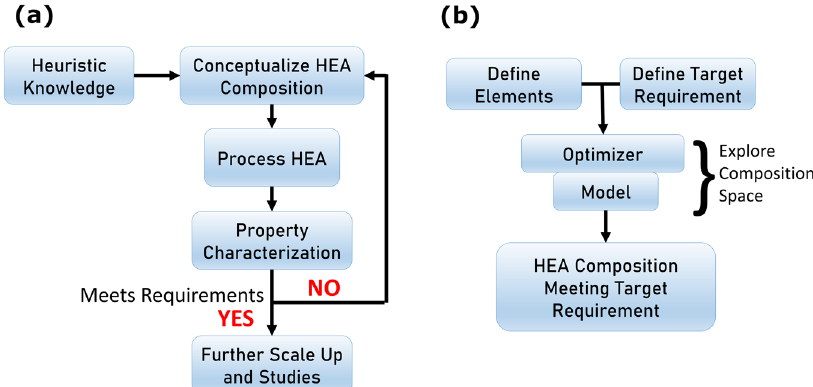
Fig. 1 Alloy development strategies. a Traditional HEA processing requires exploring the composition space experimentally to achieve a target property. This makes exploring a large HEA composition space and discovering HEAs dif fi cult, time-consuming, and expensive; b the fl owchart of the procedures which explore the composition space intelligently, using optimization coupled with a model to achieve a target requirement. The approach narrows down the search space for material scientists, potentially accelerating HEA